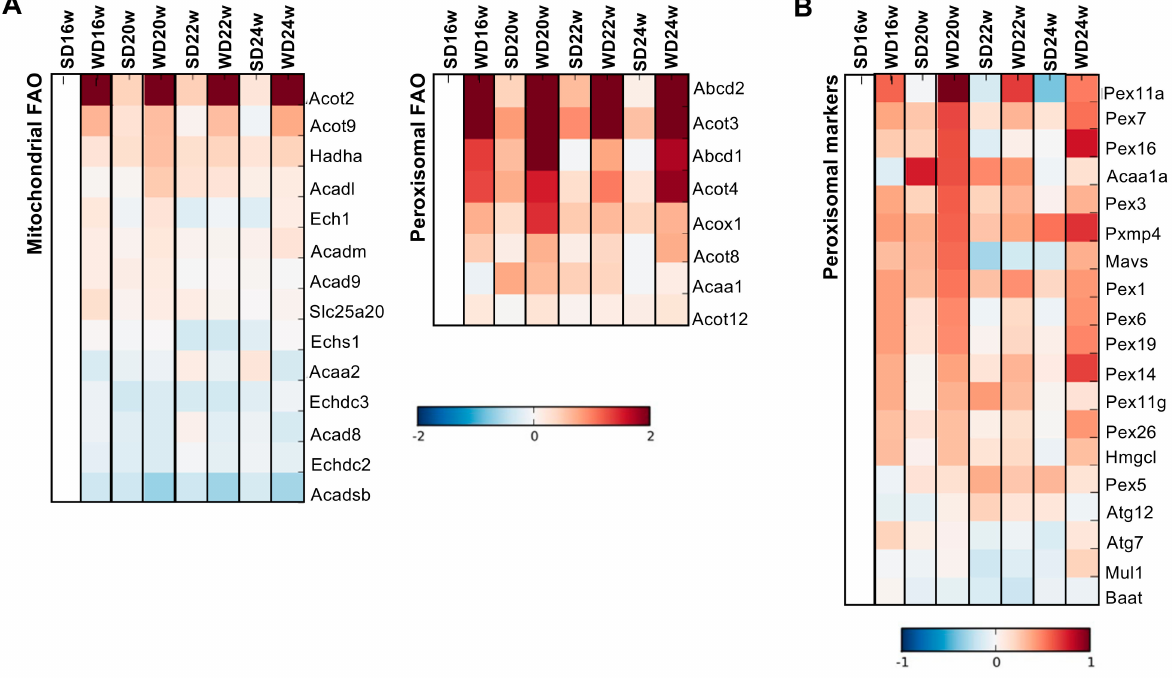
Figure 6. Western diet (WD) feeding is associated with an increment of hepatic oxidative metabolism involving mostly peroxisomes. ( A ) Mass spectrometry quantification of protein levels involved in mitochondrial FAO (left) and peroxisomal FAO (right). ( B ) Mass spectrometry quantification of protein levels of peroxisomal markers. Blue color represents decreased, and red color represents increased levels relative to the SD16w group. Number of replicates = 3. FAO, fatty acid oxidation; SD, standard chow diet; WD, Western